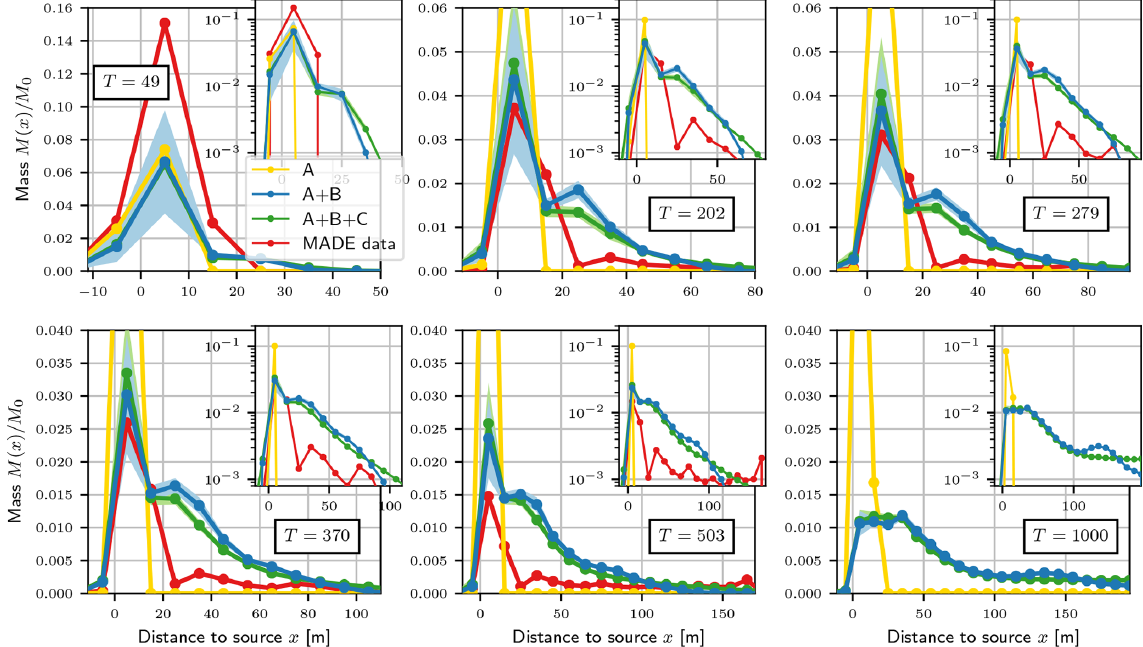
Figure 7. Mass distributions at times T = 49, 202, 279, 370, 503, and 1000d. The colour code is as follows: red denotes the MADE-1 experiment; yellow denotes concept (A); blue denotes concept (A+B); green denotes concept (A+B+C). Shaded areas (light blue and green) indicate parametric uncertainty bands; the semi-log scale is in the